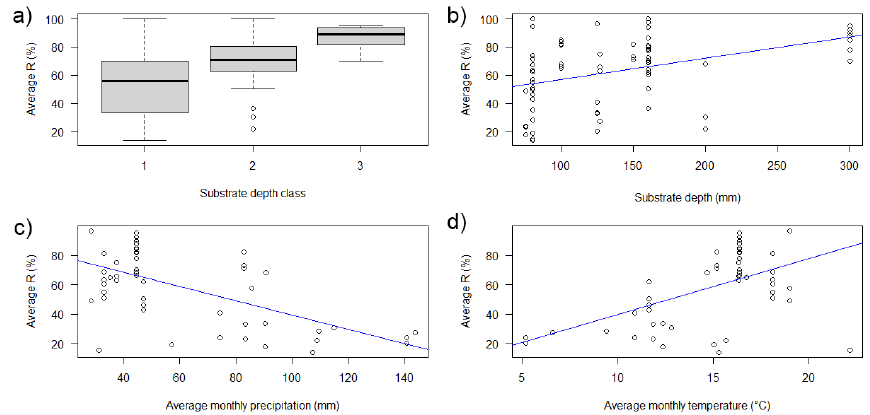
Figure 2. ( a ) Box plot for the average rainfall retention (%) according to the substrate depth class (Sample size: n Class1 = 44; n Class2 = 23; n Class3 = 8); ( b ) scatter plot for the average rainfall retention (%) according to the substrate depth ( n = 75); ( c ) scatter plot for the average rainfall retention (%) in relation to the monthly temperature ( n = 52); ( d ) scatter plot for the average rainfall retention (%) in relation to the monthly precipitation ( n = 52).